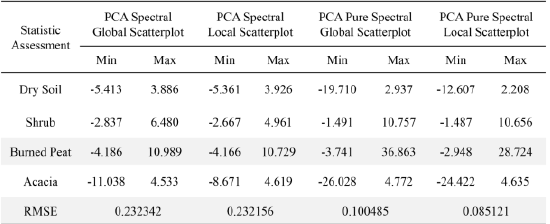
Table 1. Statistic assessment comparisons of four endmembers fraction image and estimation accuracy for four endmember selection strategies.